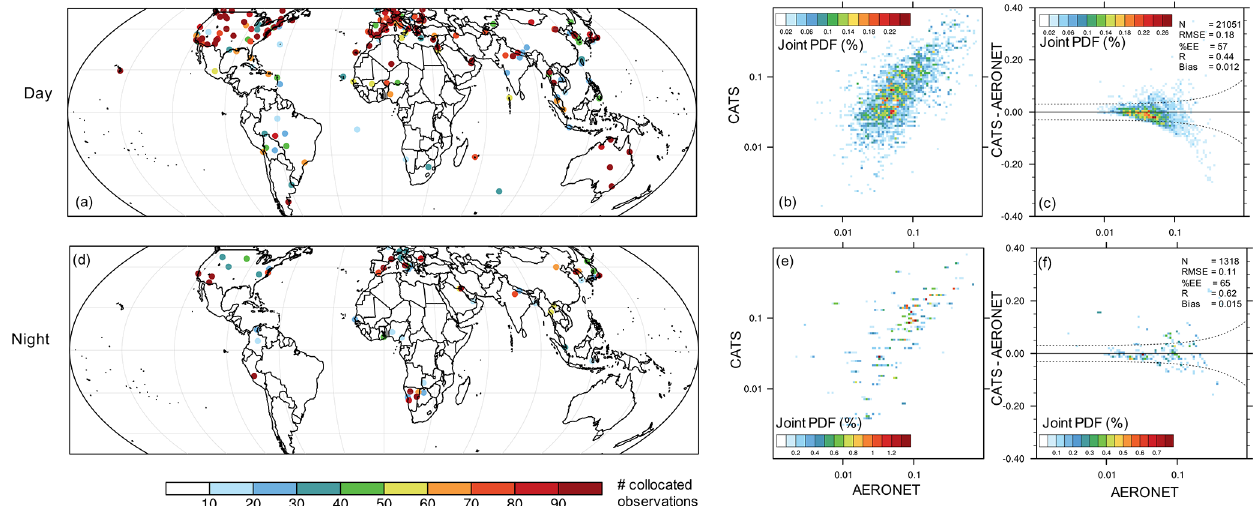
Figure 1. Comparison of total AOD from CATS (1064nm) and AERONET (1020nm) during the local (a–c) day and (d–f) night. (a, d) Number of collocated observations between CATS and AERONET. (b, e) Joint probability density (PDF, %) of collocated AOD from CATS and AERONET. (c, f) AOD difference between CATS and AERONET as a function of AERONET AOD. The dashed lines in panels (c) and (f) represent the uncertainty range of AERONET AOD. The overall collocation sample size ( N ), root-mean-squared error (RMSE), percentage of error within the AERONET uncertainty range (%EE), correlation coefficient ( R ), and mean bias for daytime and nighttime observation are indicated in panels (c) and (f)